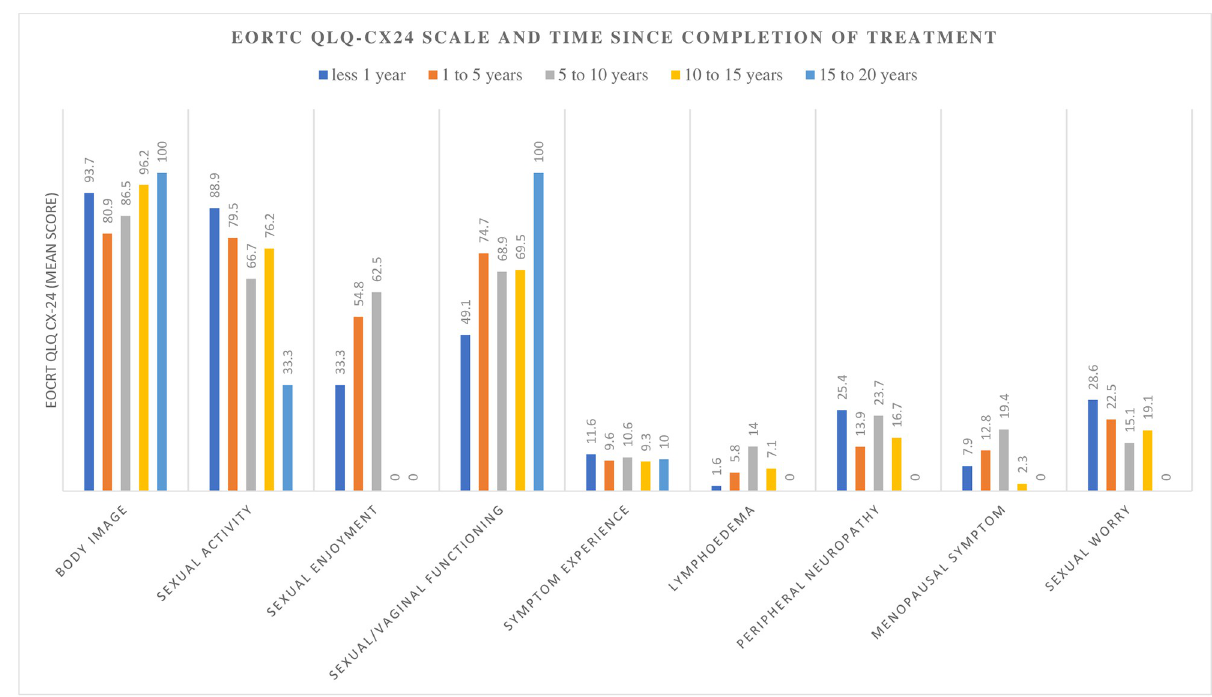
Fig 4. The change in EORTC QLQ CX-24 functioning and symptoms scores of the cervical cancer survivors after treatment at Komfo Anokye Teaching Hospital, Kumasi, Ghana.